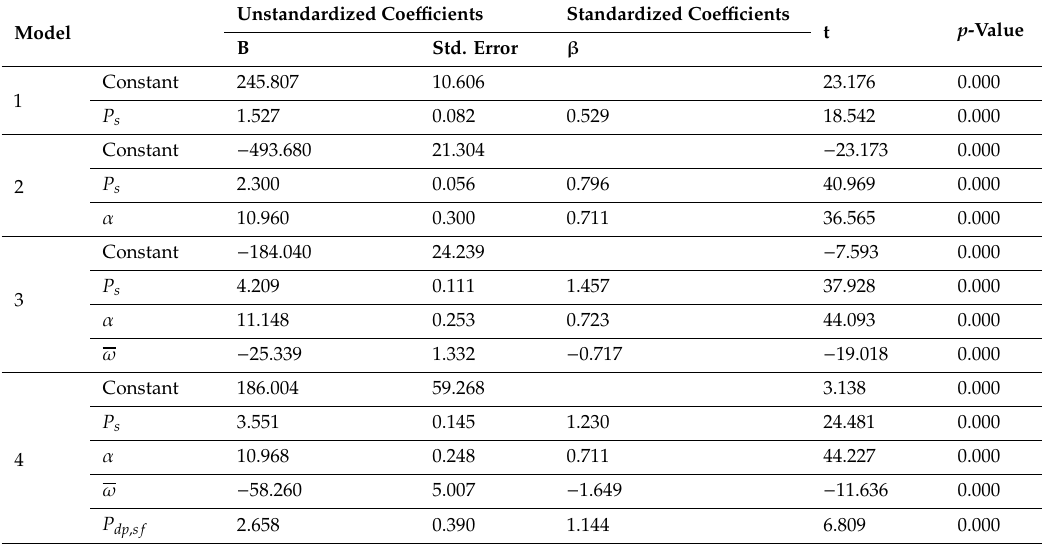
Table 7. Coe ffi cients of the